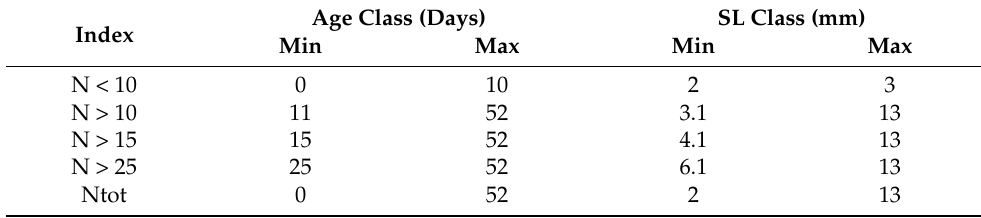
Table 2. Larvae abundance index used in the analysis. Table 3. Year–class index used for the analysis.